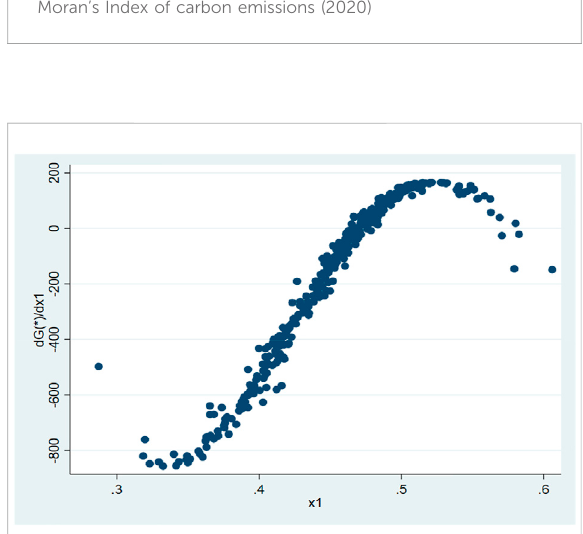
FIGURE 2 Moran ’ sIndex of high-quality economic development (2020)